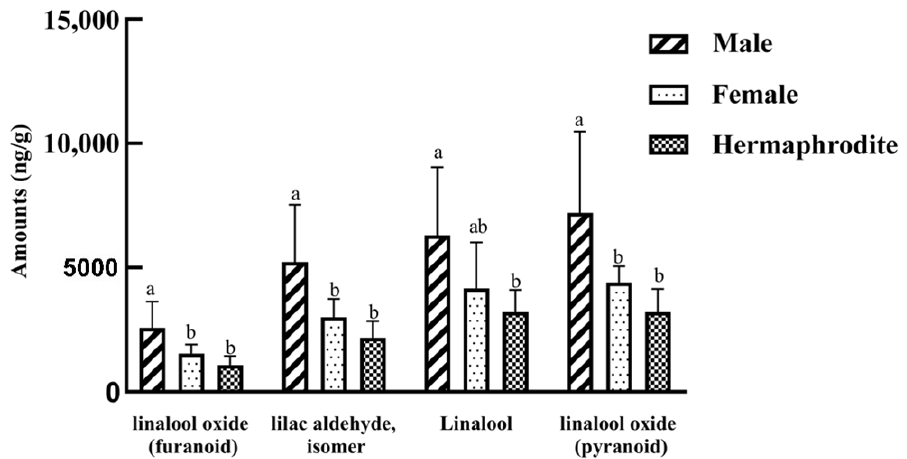
Figure 2. Comparison of major substance amounts in different sexual types. Different lower-case letters (a–c) indicate significant differences among sexes ( p < 0.05).